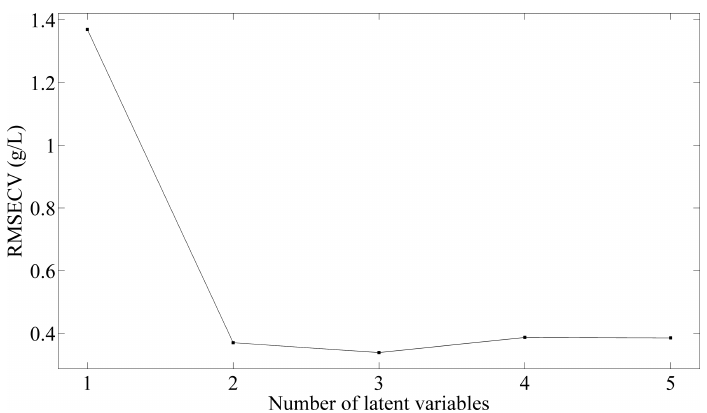
Fig. 3. E®ect of the number of latent variables on RMSECV for PLS calibration.